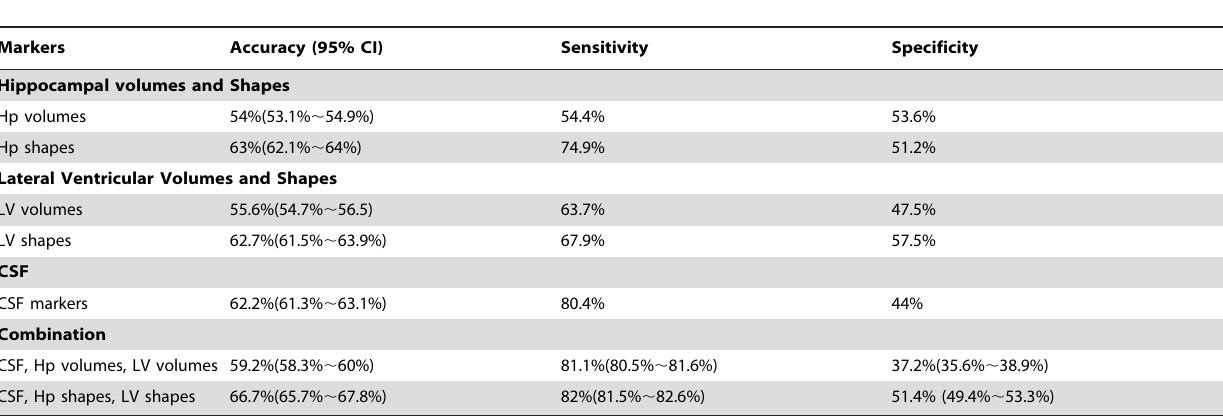
Table 4. The accuracy, sensitivity, and specificity for predicting the MCI converters are listed when the volumes or shapes of the hippocampus (Hp) or the lateral ventricles (LV), or the CSF markers, or their combination were used as features in the